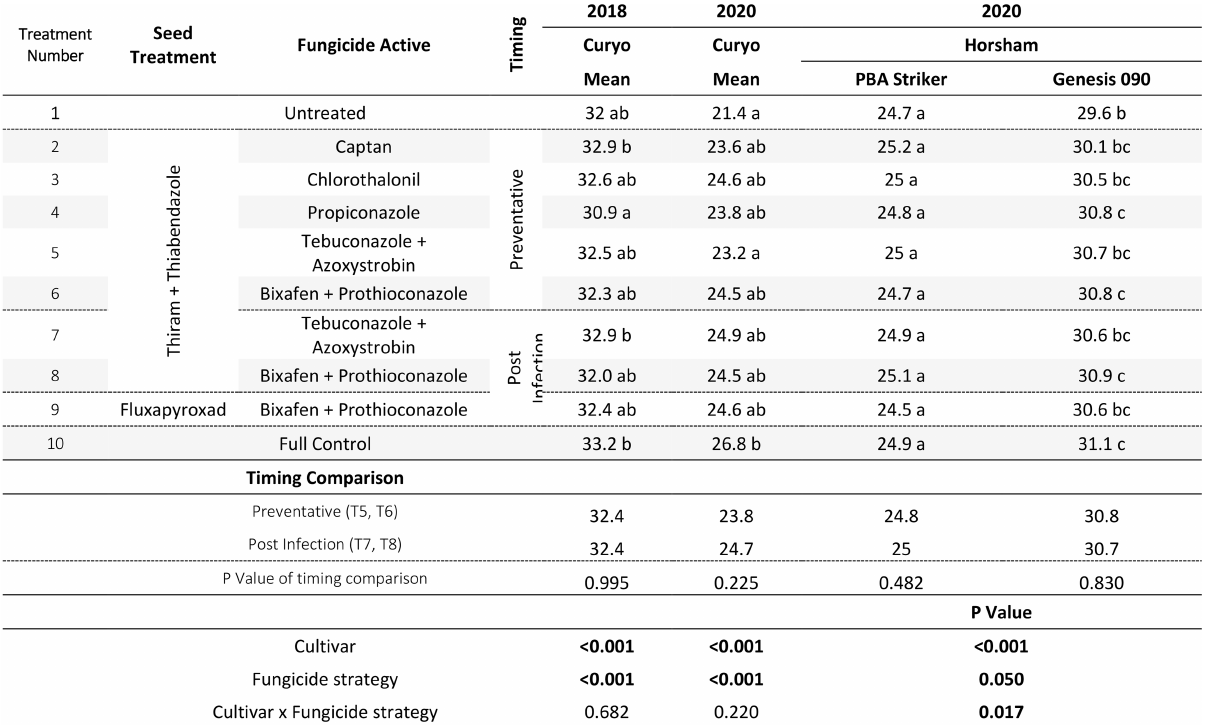
TABLE 10 Chickpea grain weight (g/100 grains) in the presence of Ascochyta blight for the significant factors in the fungicide by cultivar experiments at Curyo during 2020 and Horsham during 2020.